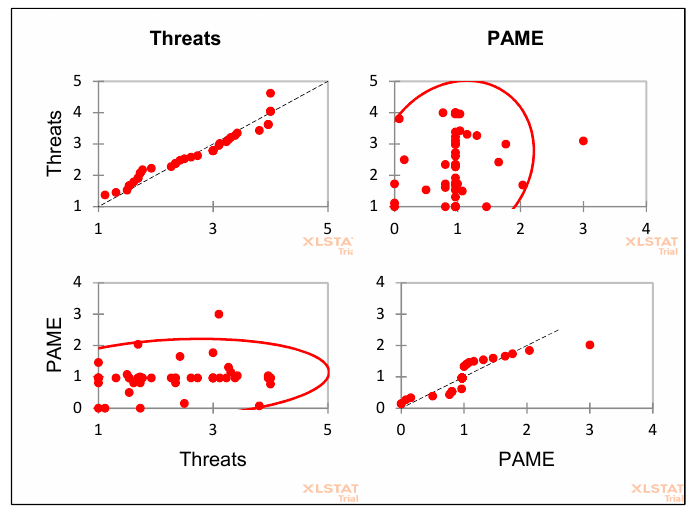
Figure 6. Correlation between Protected Areas Management and Threats .